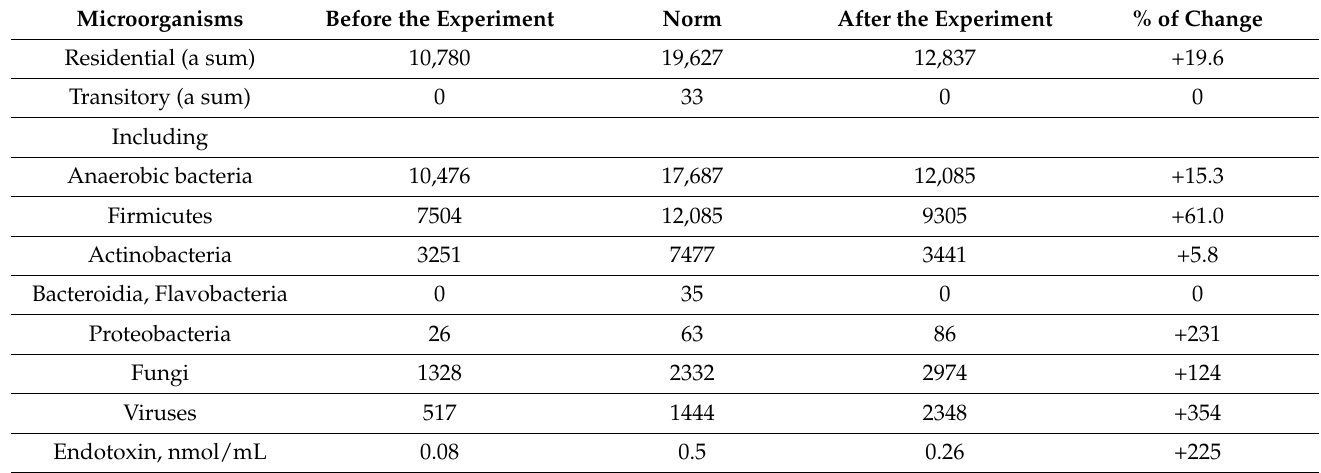
Table 2. Generalized composition of the microflora of the small intestine (10 5 cells/g)